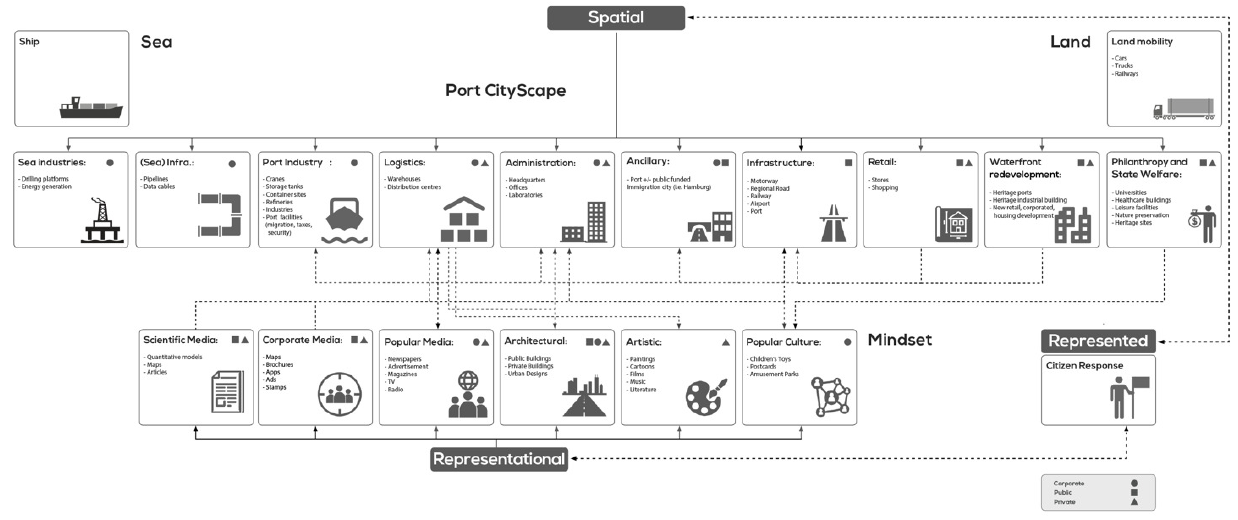
Figure 2. Port cityscape. Source: Carola